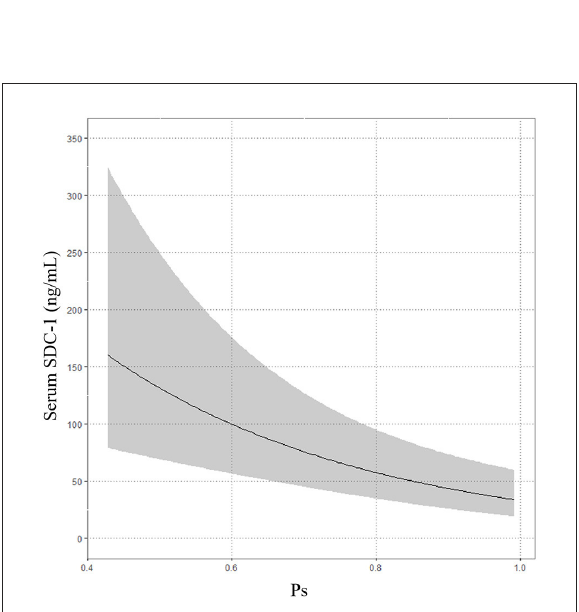
FIGURE4 Association between serum SDC-1 and probability of survival